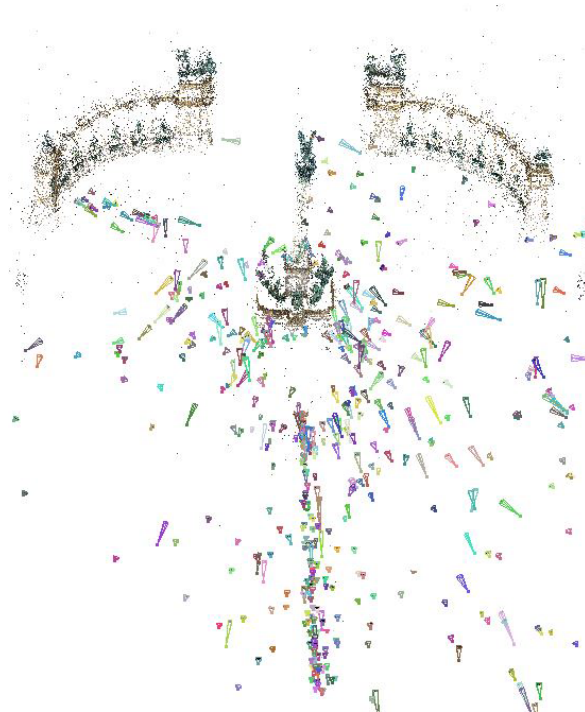
Figure 8. Reconstruction of the Heroes Square with the camera positions and orientations